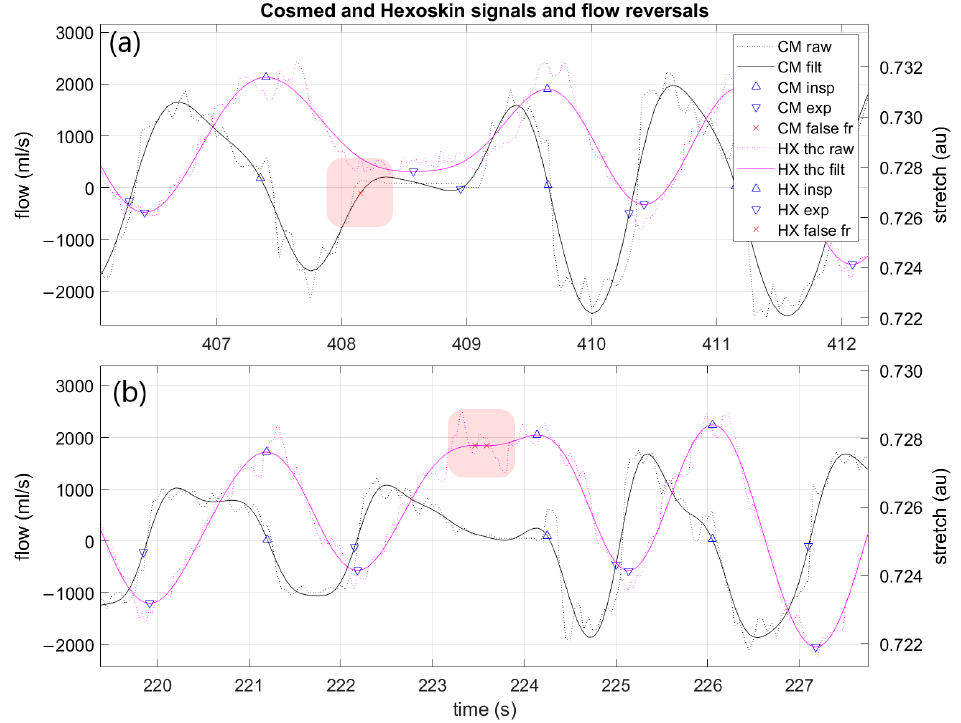
Figure 5. Example Cosmed and Hexoskin signals and detected flow reversals from one trial. Note false flow reversals labeled for removal. Cosmed error is labeled in ( a ) and Hexoskin false positives in ( b ). CM: Cosmed, HX: Hexoskin, filt: filtered, insp: inspiration, exp: expiration, fr: flow reversal.